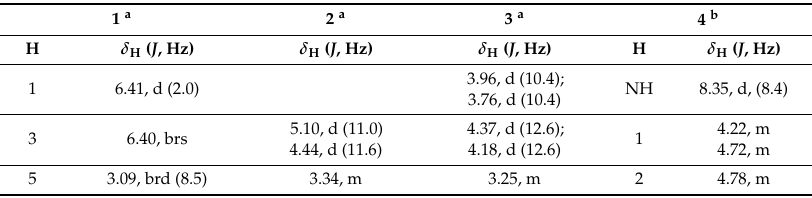
Table 1. 1 H-NMR data of compounds 1 – 4 (400 MHz, δ in ppm, J in